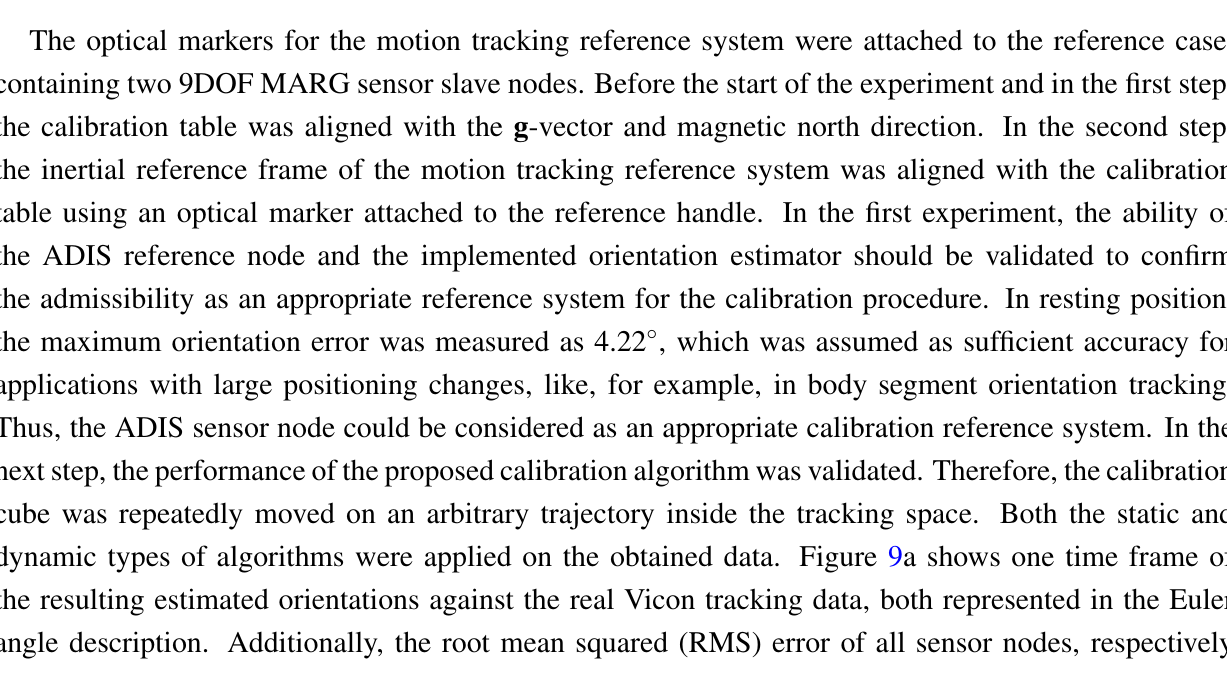
Figure 8. Overview of the components for sensor